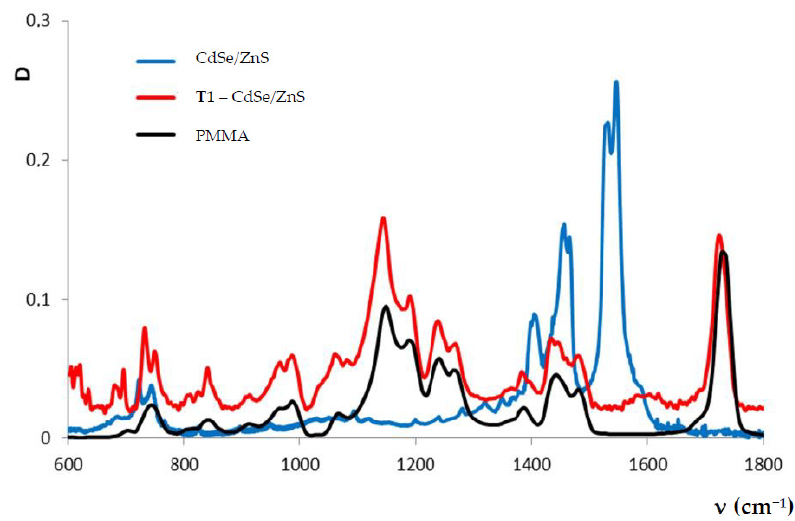
Figure 7. FTIR spectra in ATR mode of CdSe/ZnS QDs, PMMA, and T1/CdSe/ZnS QDs.